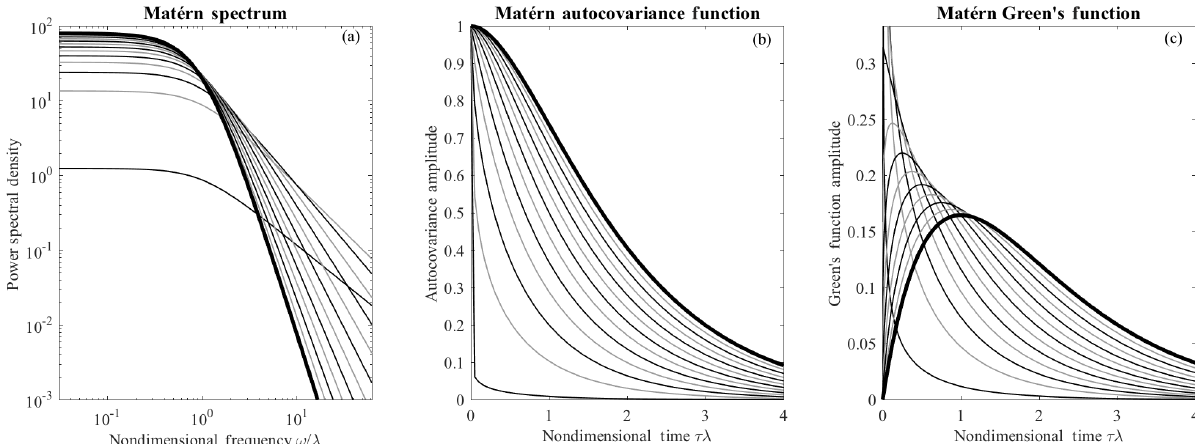
Figure 7. Theoretical spectra (a) , autocovariance functions (b) , and Green’s functions (c) for Matérn processes corresponding to the different α values shown previously in Fig. 6, and with the process variance set to σ 2 = 1. The corresponding expressions are Eqs. (47), (48), and (61), respectively. As in Fig. 6, the various α values are shown by alternating black and gray lines, with α = 2 shown as a heavy black line. Time and frequency have been nondimensionalized as τλ and ω/λ , respectively; thus the transition between a flat and a sloped regime occurs in the vicinity of ω/λ = 1 in (a) , while the e -folding time in (c) is τλ = 1. The autocovariance function (b) develops a strong singularity as α approach 1 / 2, which is linked to the flattening of the spectrum in (a) . The Green’s function in (c) is infinite at τλ = 0 for α < 1, and vanishes at τλ = 0 for α >